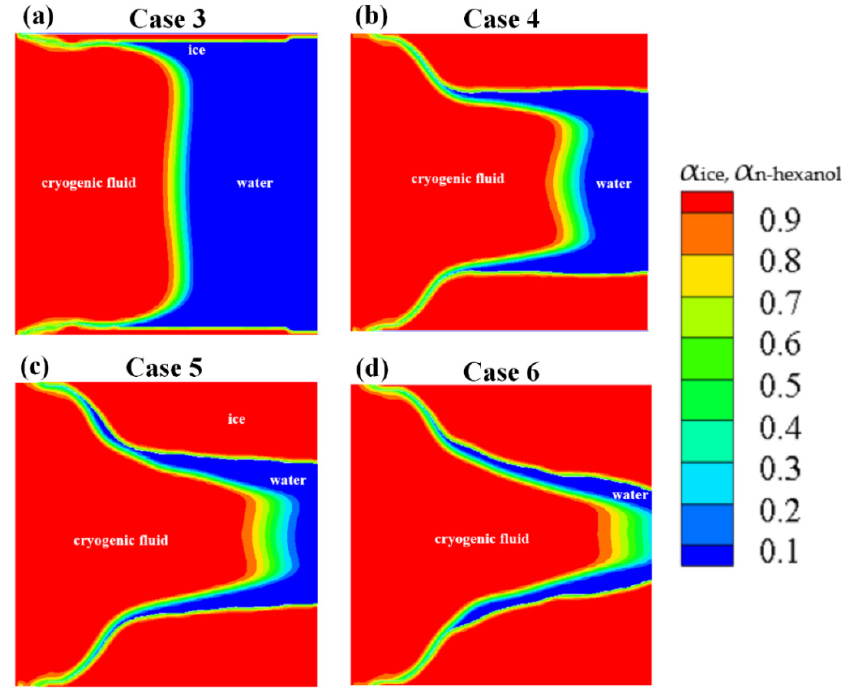
Figure 13. Distributions of cryogenic fluid, water and ice (phase fraction) at t = 0.5 s under different initial ice phase distribution state ( a ) Case 3, ( b ) Case 4, ( c ) Case 5, and ( d ) Case 6.